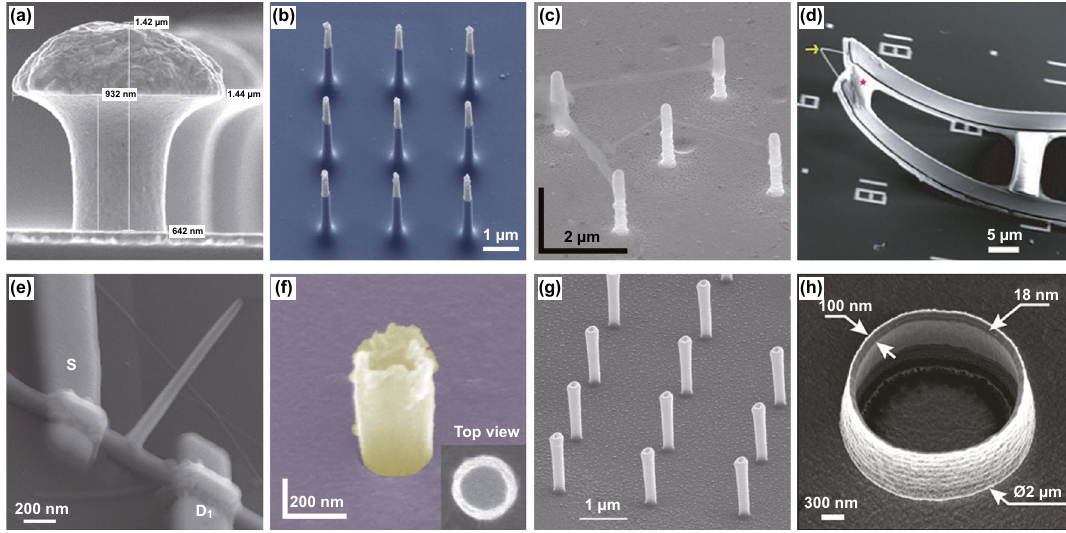
Fig. 2 Nanodevices with different materials and geometric shapes. a SEM image of the gold-spine electrode. Reproduced with permission from Ref. [98]. Copyright 2010, American Physiological Society. b SEM image of the vertical nanowire electrode array with silicon core and gold tip. Reproduced with permission from Ref. [89]. Copyright 2012, Nature. c SEM image of the vertical Pt nanopillar electrode array. Reproduced with permission from Ref. [91]. Copyright 2012, Nature. d SEM image of the device based on the kinked silicon nanowire. Reproduced with permission from Ref. [87]. Copyright 2010, American Association for the Advancement of Science. e SEM image of branched SiO 2 nanotube field-effect transistor. Reproduced with permission from Ref. [102]. Copyright 2011, Nature. f SEM image of the IrOx nanotube electrode. Reproduced with permission from Ref. [101]. Copyright 2014, Nature. g SEM image of gold-coated plasmonic 3D nanoelectrodes. Reproduced with permission from Ref. [100]. Copyright 2017, American Chemical Society. h SEM image of the nanovolcano electrode with Au nanoring. Reproduced with permission from Ref. [10]. Copyright 2019, American Chemical